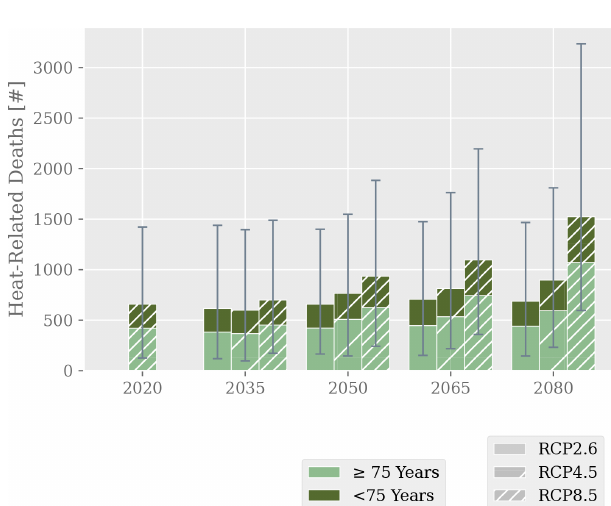
Figure 4. Median of the number of heat-related deaths calculated in the Monte Carlo simulation for the baseline (2020, RCP8.5) and the years 2035, 2050, 2065, and 2080 under the three RCP scenar- ios. The uncertainty estimate corresponds to the 90% confidence interval.